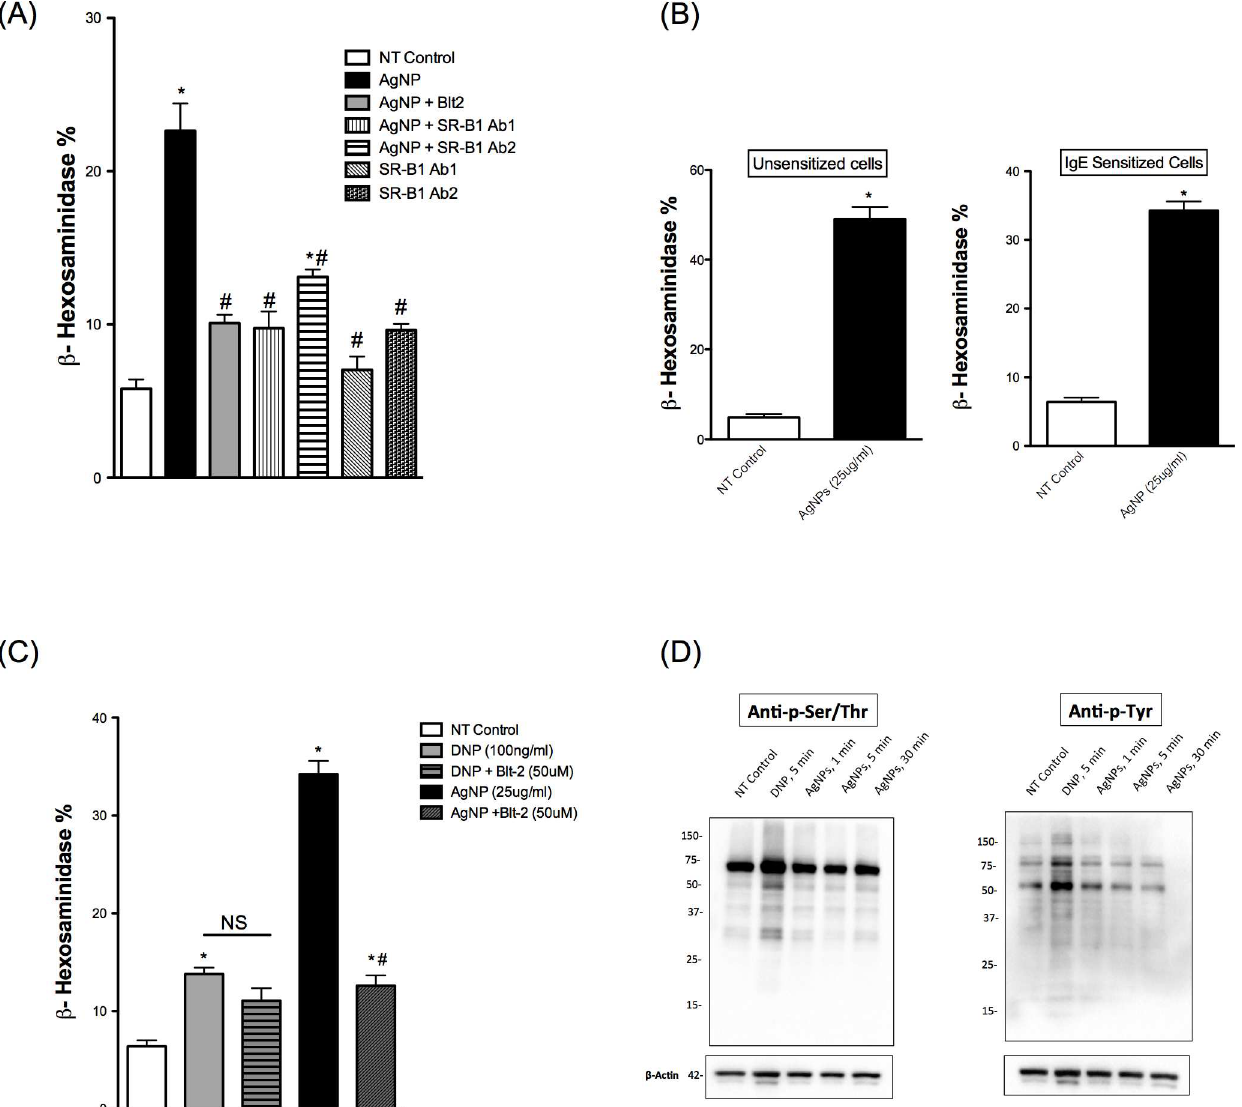
Fig 2. Mast cell degranulation following exposure to AgNPs Mast cell degranulation was assessedby measuring the release of β - hexosaminidase into supernatants. (A) Cells were pre-treatedwith the SR-B1 inhibitorBlt-2 (50 μ M), SR-B1 specific antibodies(1:100 dilution) 30 min prior to AgNP (25 μ g/ml) exposurefor 1h and release of β -hexosaminidasewas assessed. (B) Cells were sensitizedwith anti-DNP IgE overnightand then exposedto AgNPs (25 μ g/ml) for 1 h and release of β -hexosaminidasewas assessed. (C) Cells were pre-treatedwith Blt-2 (50 μ M) for 30 min then activated with either DNP (30 min) or AgNP (1 h) and release of β -hexosaminidasewas assessed. (D) Representative immunoblots for globalp-Tyr and p-Ser/Thr followingDNP (100 ng/ml) or AgNPs (25 μ g/ml) exposure. Values are expressedas mean ± SEM of at least 3 independentexperiments. * Indicatessignificantdifference from controlledgroup (p (cid:20) 0.05).#Indicatessignificantdifference from AgNP-treatedgroup (p (cid:20)